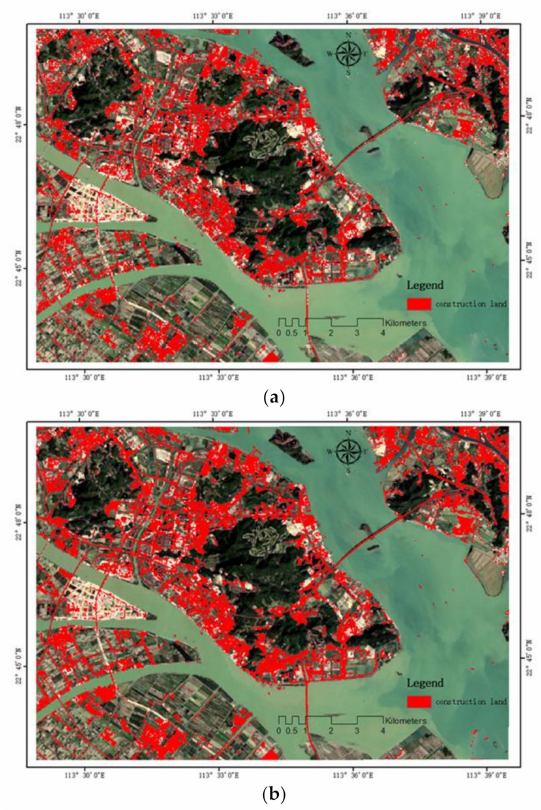
Figure 10. Comparison of the extraction results of impervious surfaces between the images before and after super-resolution (Figure ( a ) is the extraction result on the image before super-resolution and Figure ( b ) is the extraction result on the image after super-resolution).